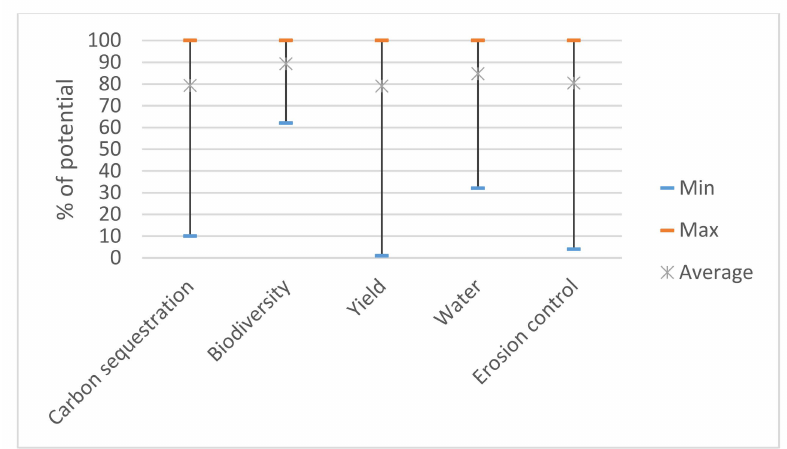
Figure A3. Demand stated for ES in all three CSAs.